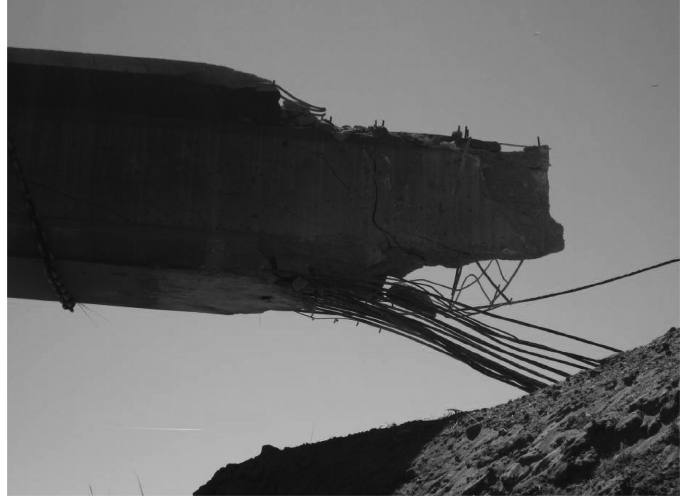
Fig. 15. Damaged section with rubbelized concrete removed (adopted from [12]).